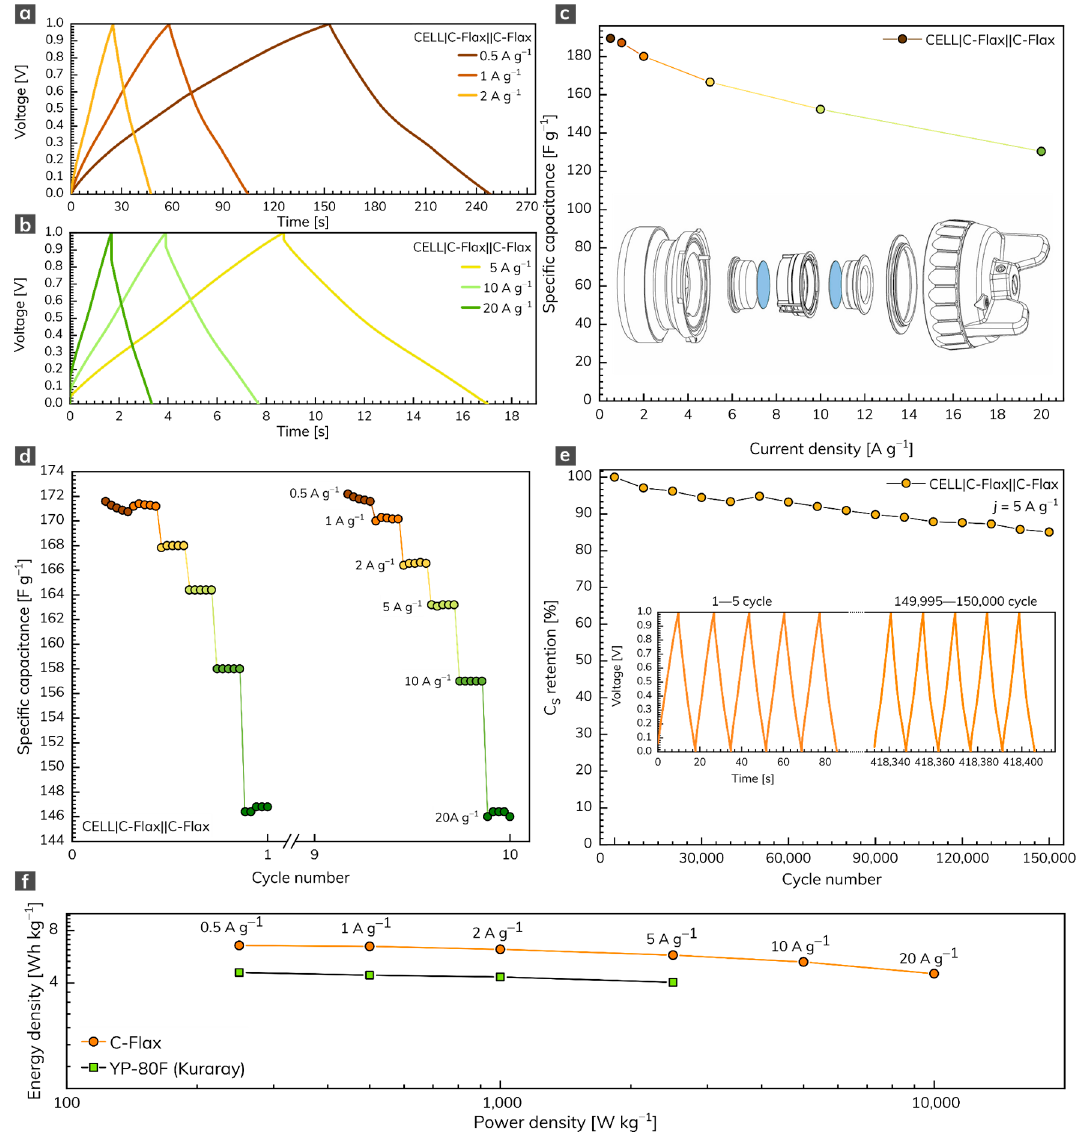
Figure 4. ( a , b ) GCD profiles of C-Flax material recorded at different current densities and ( c ) corresponding specific capacitance vs. current density profile. ( d ) Rate-test of C-Flax sample recorded at current densities ranging from 0.5 to 20 A g − 1 . ( e ) Specific capacitance retention of C-Flax sample after 150,000 GCD cycles. ( f ) Ragone plot of C-Flax and YP-80F (Kuraray) sample. All experiments were performed in 1 mol L –1 sulfuric acid.